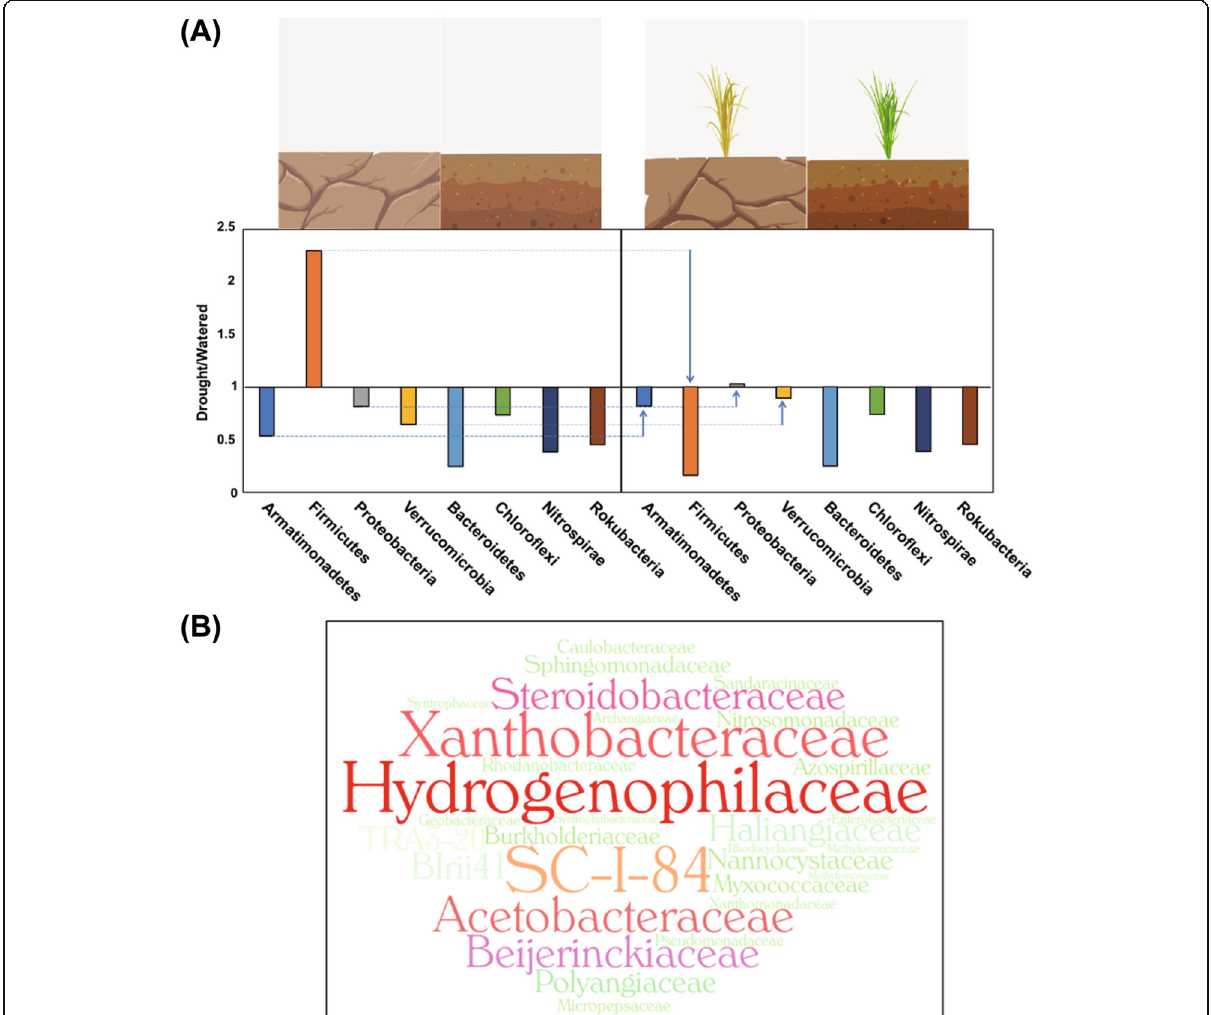
Fig. 4 Model of the microbiome shift following a change in soil state and the presence of plants. The microbial shift produces two distinct clusters and suggests the dominance of six families belong to Proteobacteria under drought condition. a The left panel shows the ratio of drought to watered condition in the absence of plant for eight phyla and right one shows the ratio in the presence of plant for eight phyla selected from two clusters affected by drought. When watered soil with plants shift to drought with plants, phyla showing significant population shift are indicated with vertical arrows and dotted lines ( p -value < 0.05; two-way ANOVA of both factors) (Table S6). The x-axis represents the ratio of drought to watered condition and y-axis indicates eight phyla significantly affected by drought. b The WordCloud refers to 13 families within the Proteobacteria that shift significantly as a cluster in the presence of both drought stress and plants (Table S9). Six families have statistically significant p -values and are presented in bigger size of letters with different color; these exhibit the same pattern as Proteobacteria in response to drought conditions in the presence of plants. The word sizes indicate the relative abundance ratio under drought